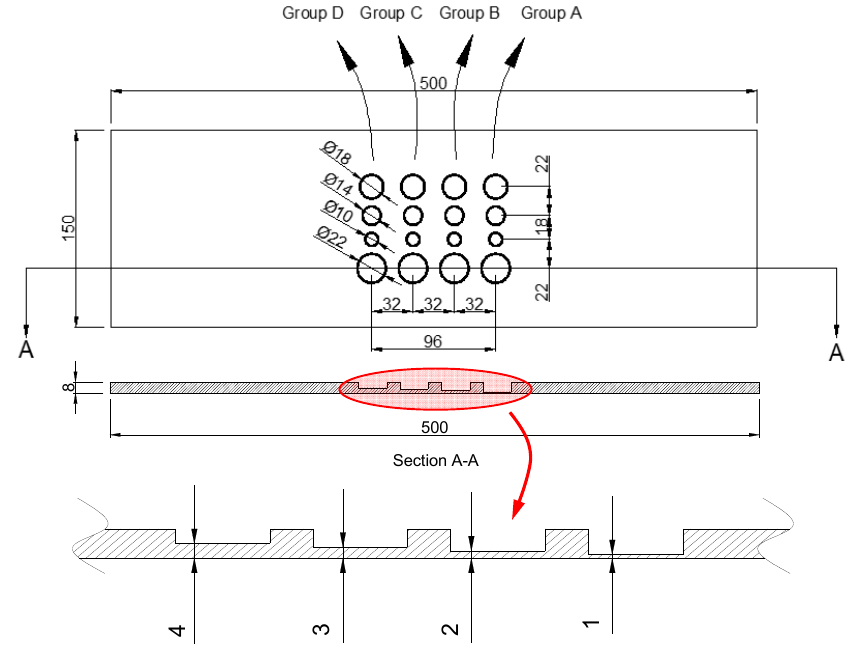
Table 2. The arrangement of depth and size of artificial defects.